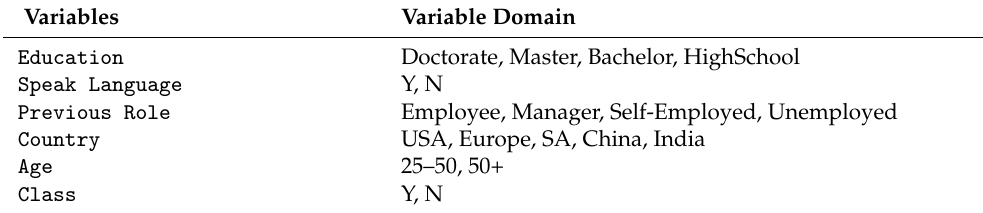
Table 4. Variables used for the generation of the synthetic dataset along with their